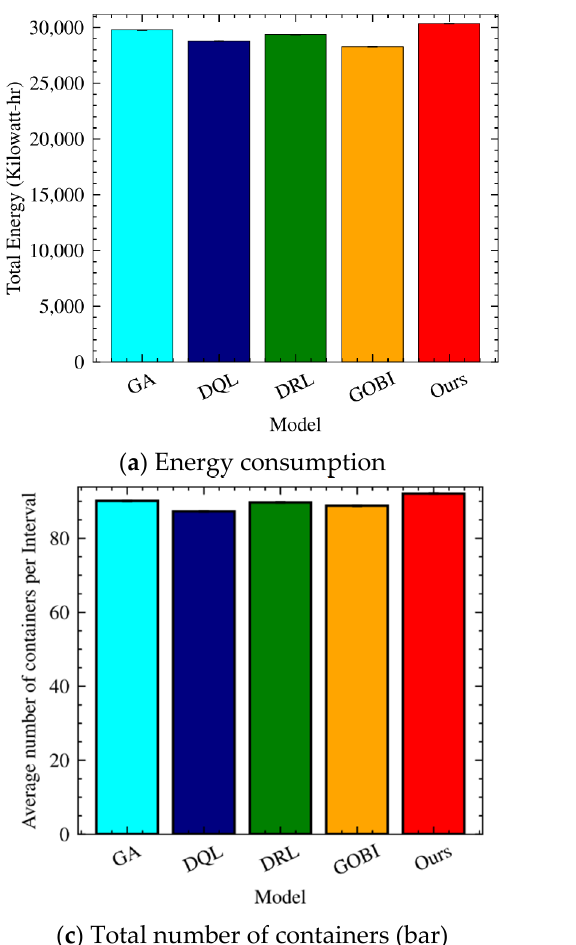
Figure 5. Energy consumption, cost per container, total number of containers, and average number of containers with ten hosts.